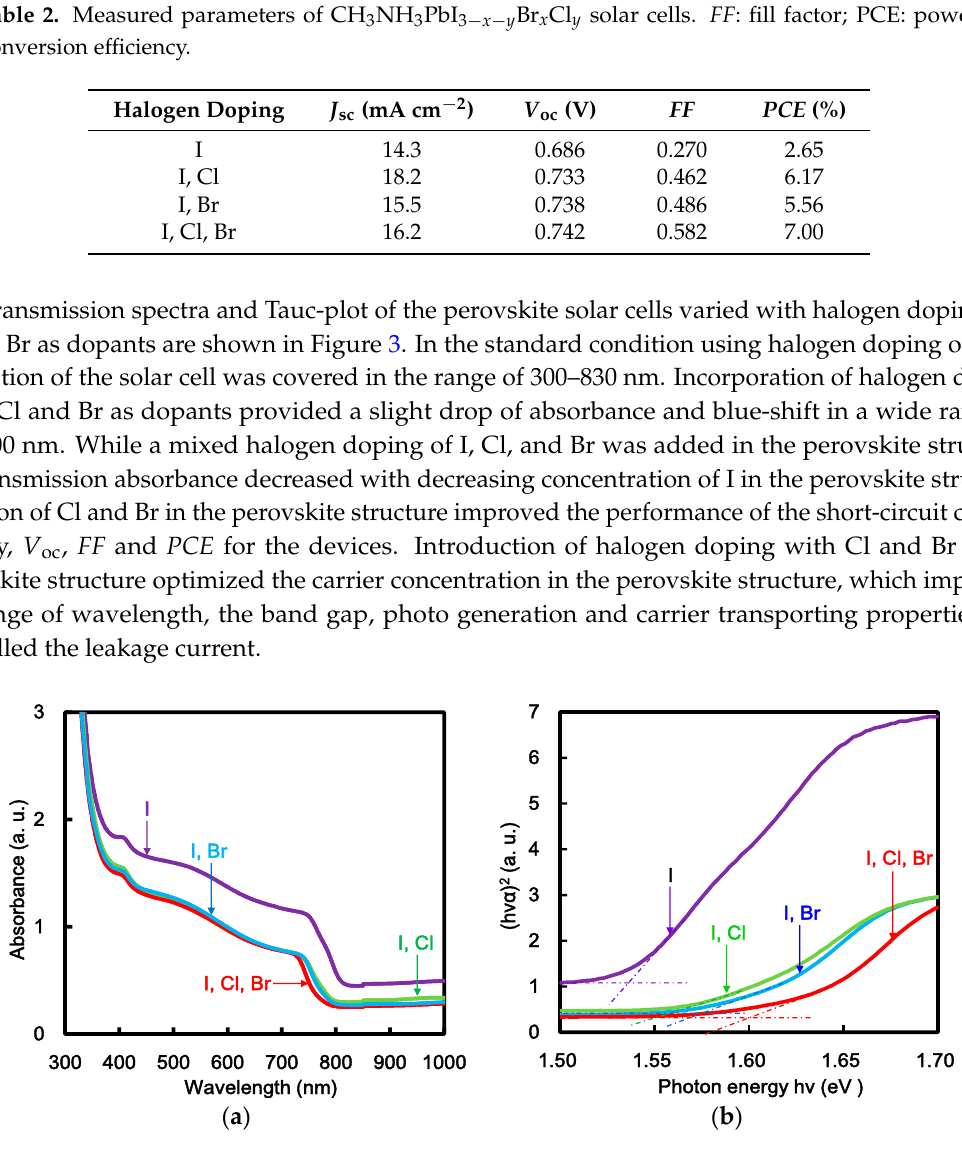
Figure 3. ( a ) Transmission spectra; and ( b ) Tauc ‐ plots of FTO/TiO 2 /CH 3 NH 3 PbI 3 − x − y Br x Cl y cells.